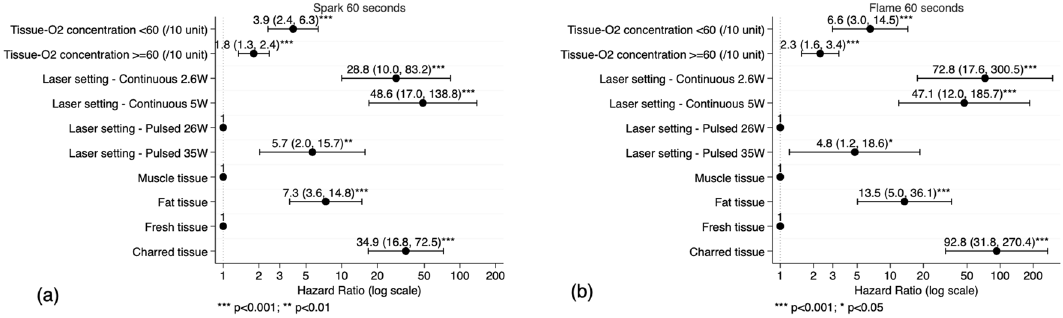
Figure 4. Coefficient plot from multivariate Cox proportional hazard models of ( a ) spark and ( b ) flame censored after 60 s from ex-vivo experimental